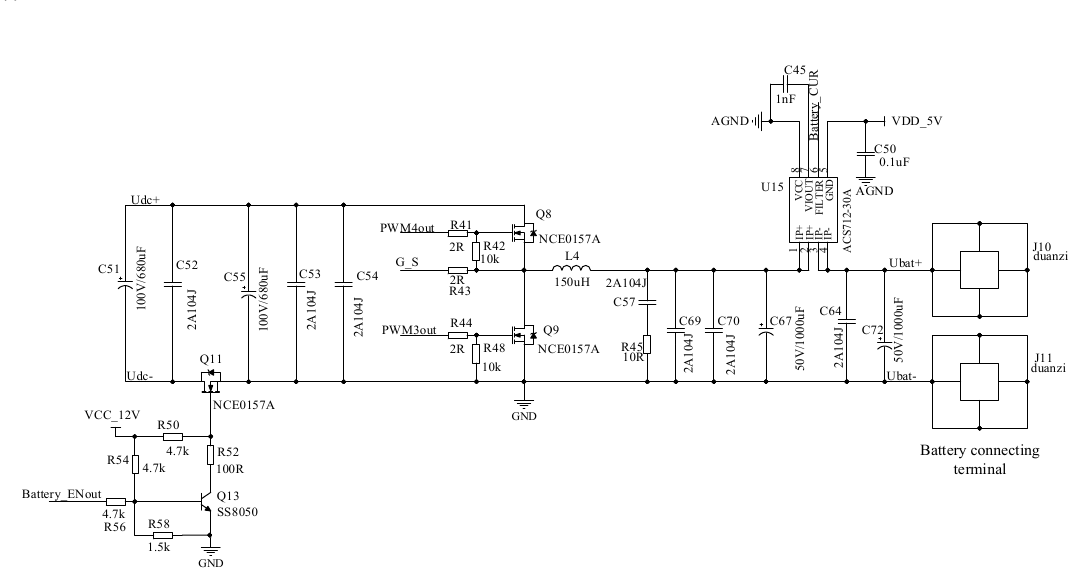
Figure 12. Battery charge and discharge circuit.